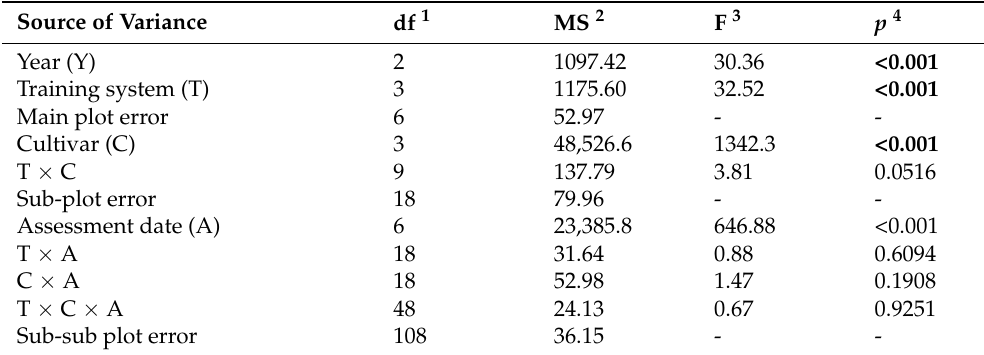
Table 3. Analyses of variance for the effects of years (2017, 2018 and 2019); training systems (4 × 1.5, 4 × 2, 5 × 2.5 and 6 × 3 m); cultivars (‘ ˇCaˇcanska lepotica’, ‘Bluefre’, ‘Stanley’ and ‘President’); and assessment dates (days 0, 30, 60, 90, 120, 150 and 180) on incidences of shot hole disease in an integrated plum orchard at Debrecen-Pallag, East Hungary. Bold figures indicate significant differences at p <